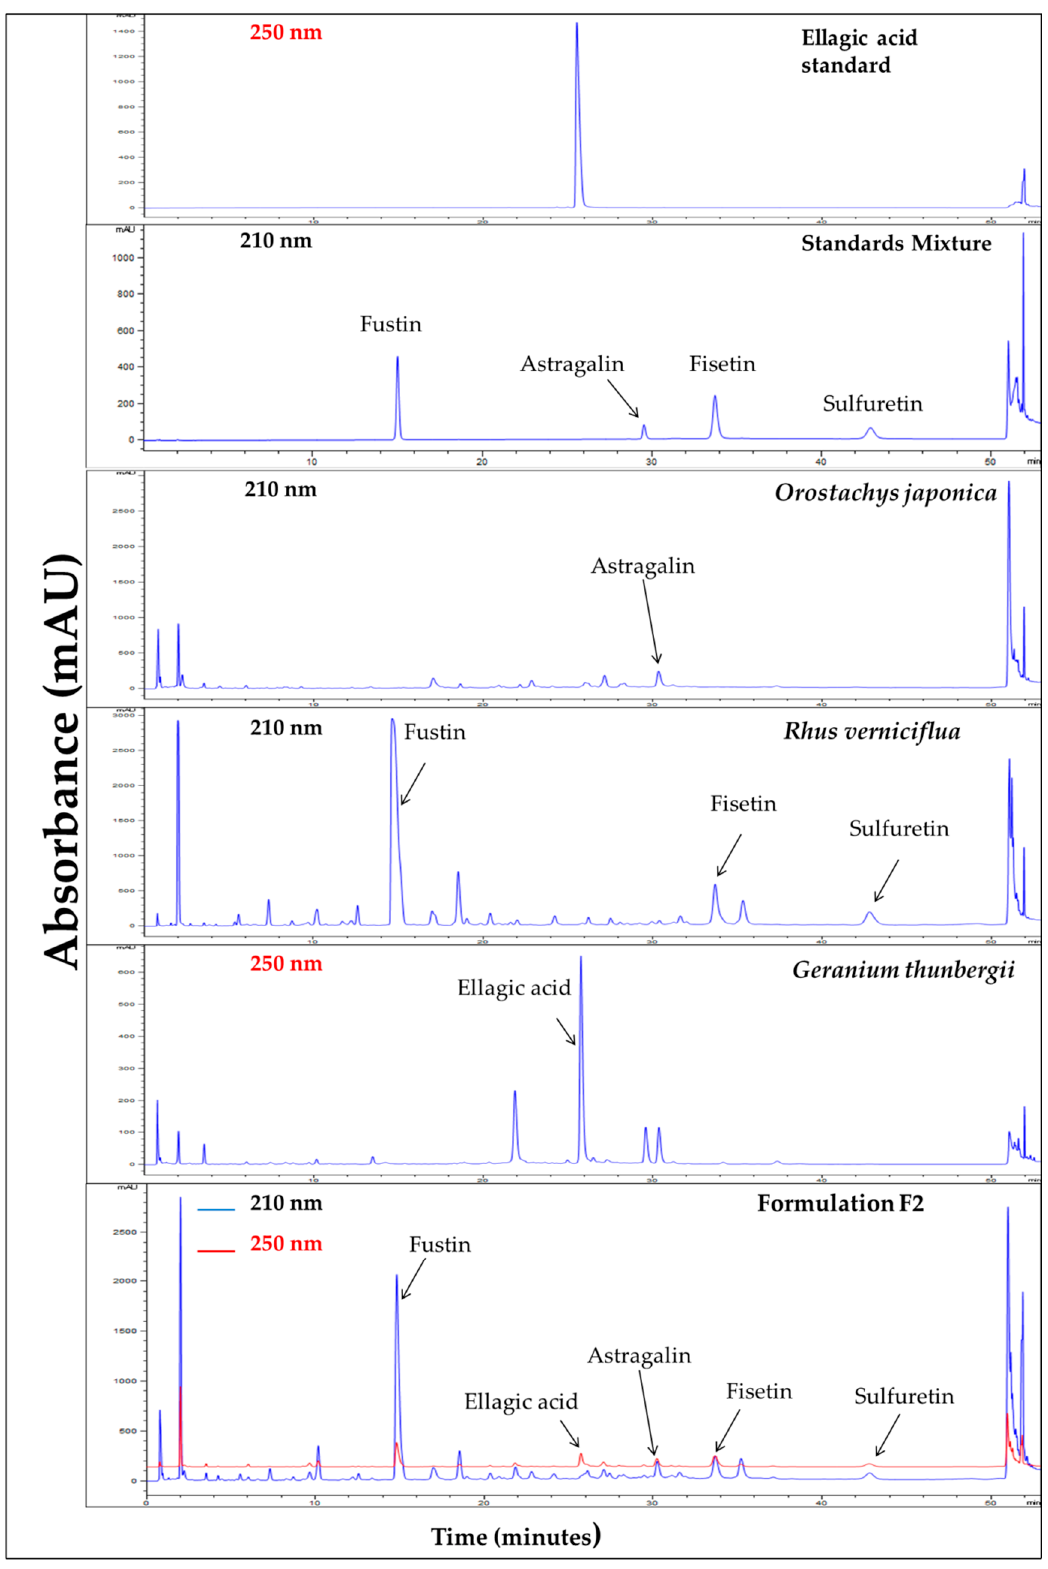
Figure 1. UPLC chromatograms of Formulation F2 along with standard compounds (ellagic acid, fustin, astragalin, fisetin, sulfuretin) and plant ingredients ( O. japonica, R. verniciflua, and G. thunbergii )